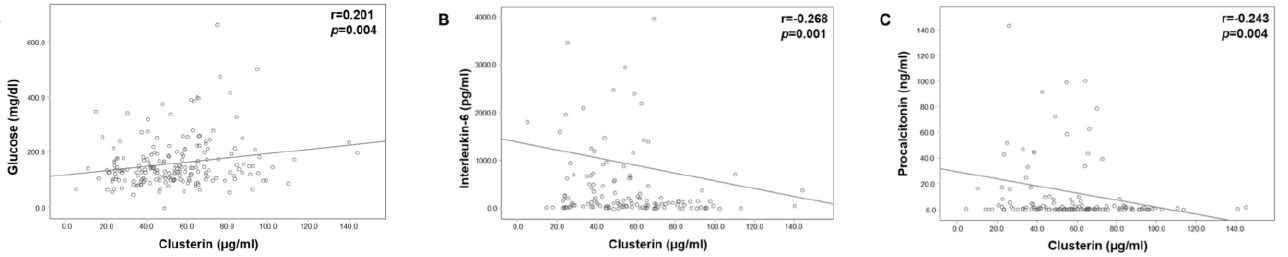
Figure 4. Clusterin levels correlate with glucose as well as inversely with inflammatory parameters. Correlation analyses revealed associations between plasma clusterin and plasma glucose ( A ), inter- leukin-6 ( B ), and procalcitonin ( C ), respectively. p -values (U-test) are given in the figure.